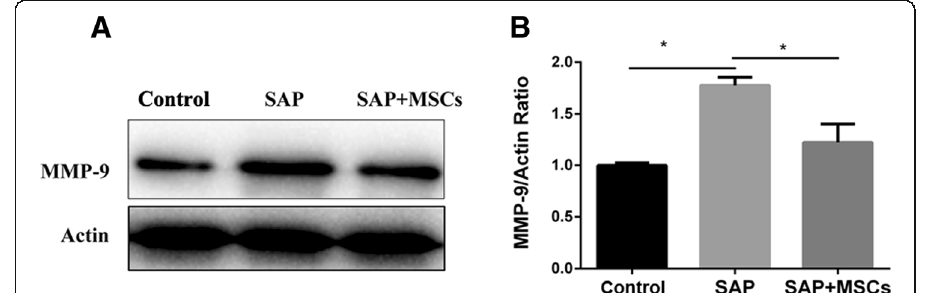
Fig. 7 MSCs attenuated the upregulation of MMP-9 in the brains of SAP rats. a Representative western blotting image of the MMP-9 protein expression in the brains of SAP rats. b Statistical analysis of the MMP-9 protein expression based on a western blotting assay. * p <